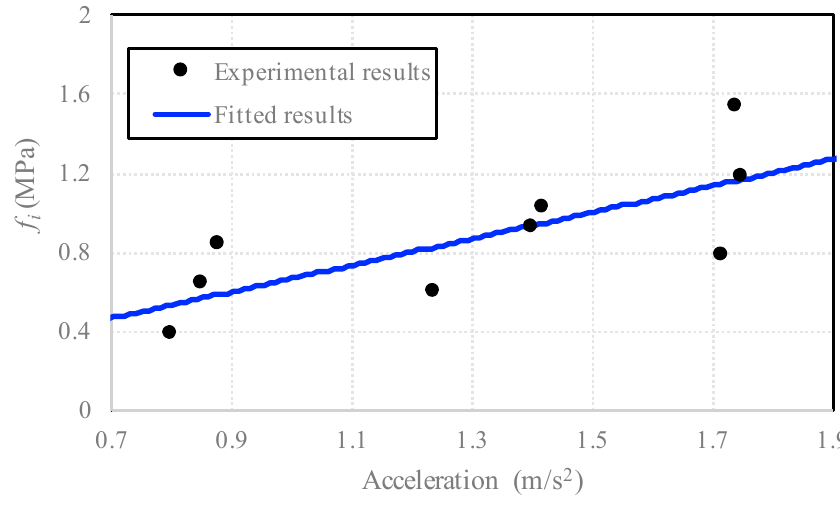
Figure 14. The dynamic inertia contribution with respect to the acceleration.